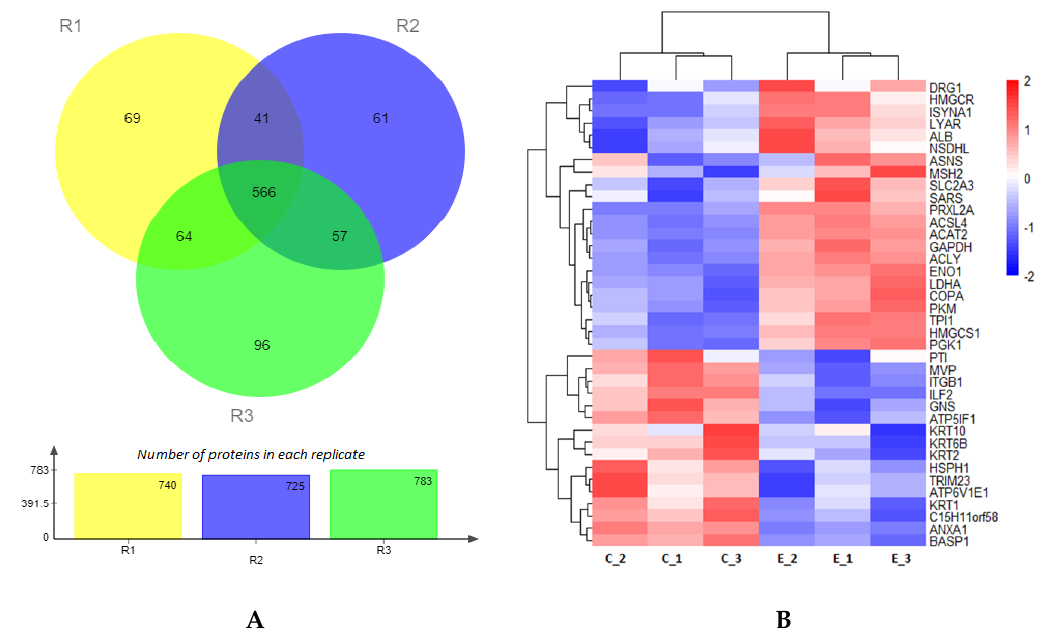
Figure 6. Protein profile obtained by labelled iTRAQ LC-MS / MS Analysis. Venn diagram showing the overlap of the quantified proteins within the three replicates (R1, R2 and R3). About 72.28% (566) of all the proteins (954) were found in every replicate, showing the good conformance of the samples ( A ). Heatmap presenting the distribution of di ff erentially expressed proteins (log 2 FC [ 5% ] > 20%, p < 0.05). Pink and blue bars showing proteins that are significantly upregulated (25) and downregulated (18) in the 5% oxygen group in comparison with 20% oxygen group ( B ). The uncharacterized di ff erentially expressed proteins have been omitted from the heatmap. C and E correspond to 20% and 5% oxygen, respectively.